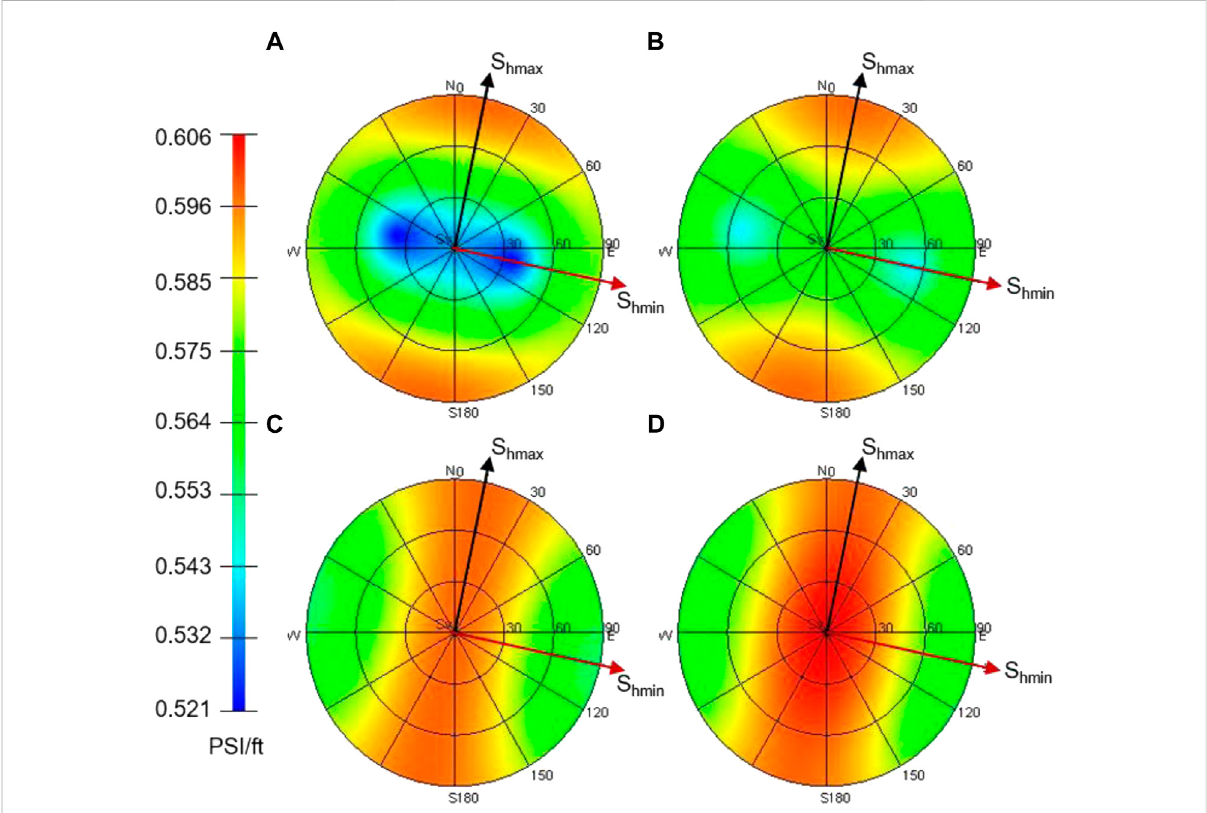
FIGURE 5 Safe wellbore trajectory analysis and minimum mud pressure requirements (refer to the colour bar for mud pressure gradient scale) to avoid compressive wellbore failure, (A) S hmax << S v , (B) S hmax < S v , (C) S hmax = S v and (D) S hmax > S v . In this mud pressure circular plot (lower hemisphere plot) wellazimuth isplotted alongtheperipheryofthecircleand wellinclinationisplottedalongtheradius.Centre ofeach circledenotesthevertical well position, and a horizontal well at any azimuth will be plotted on the